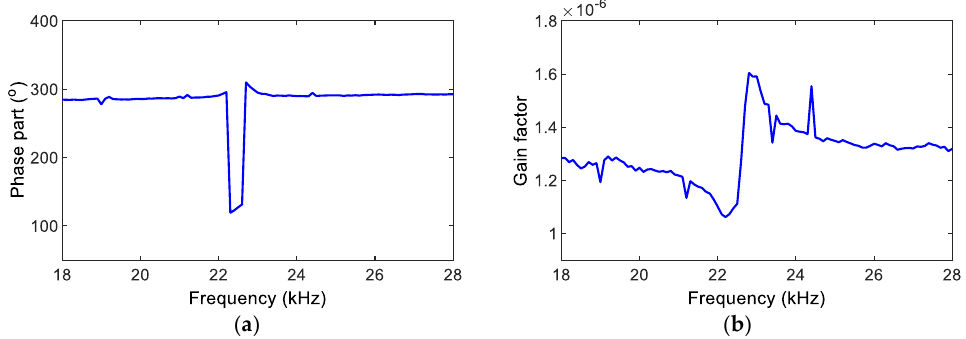
Figure 15. Calculation of impedance phase gap and gain factor for SSeL-Pi system. ( a ) Phase gap ϕ 1 , j , ( b ) Gain factor G 1 1